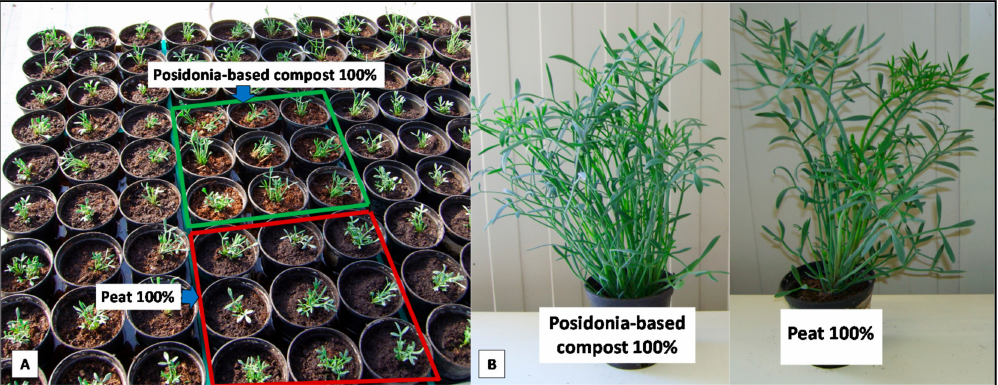
Figure 1. Example of organic renewable materials tested in soilless cultivation: potted sea fennel ( Crithmum maritimum L.) grown by using posidonia-based materials as a peat substitute without any negative effect on plant growth in comparison with a commercial peat substrate; sea fennel plants after transplanting ( A ) and at harvesting time ( B )